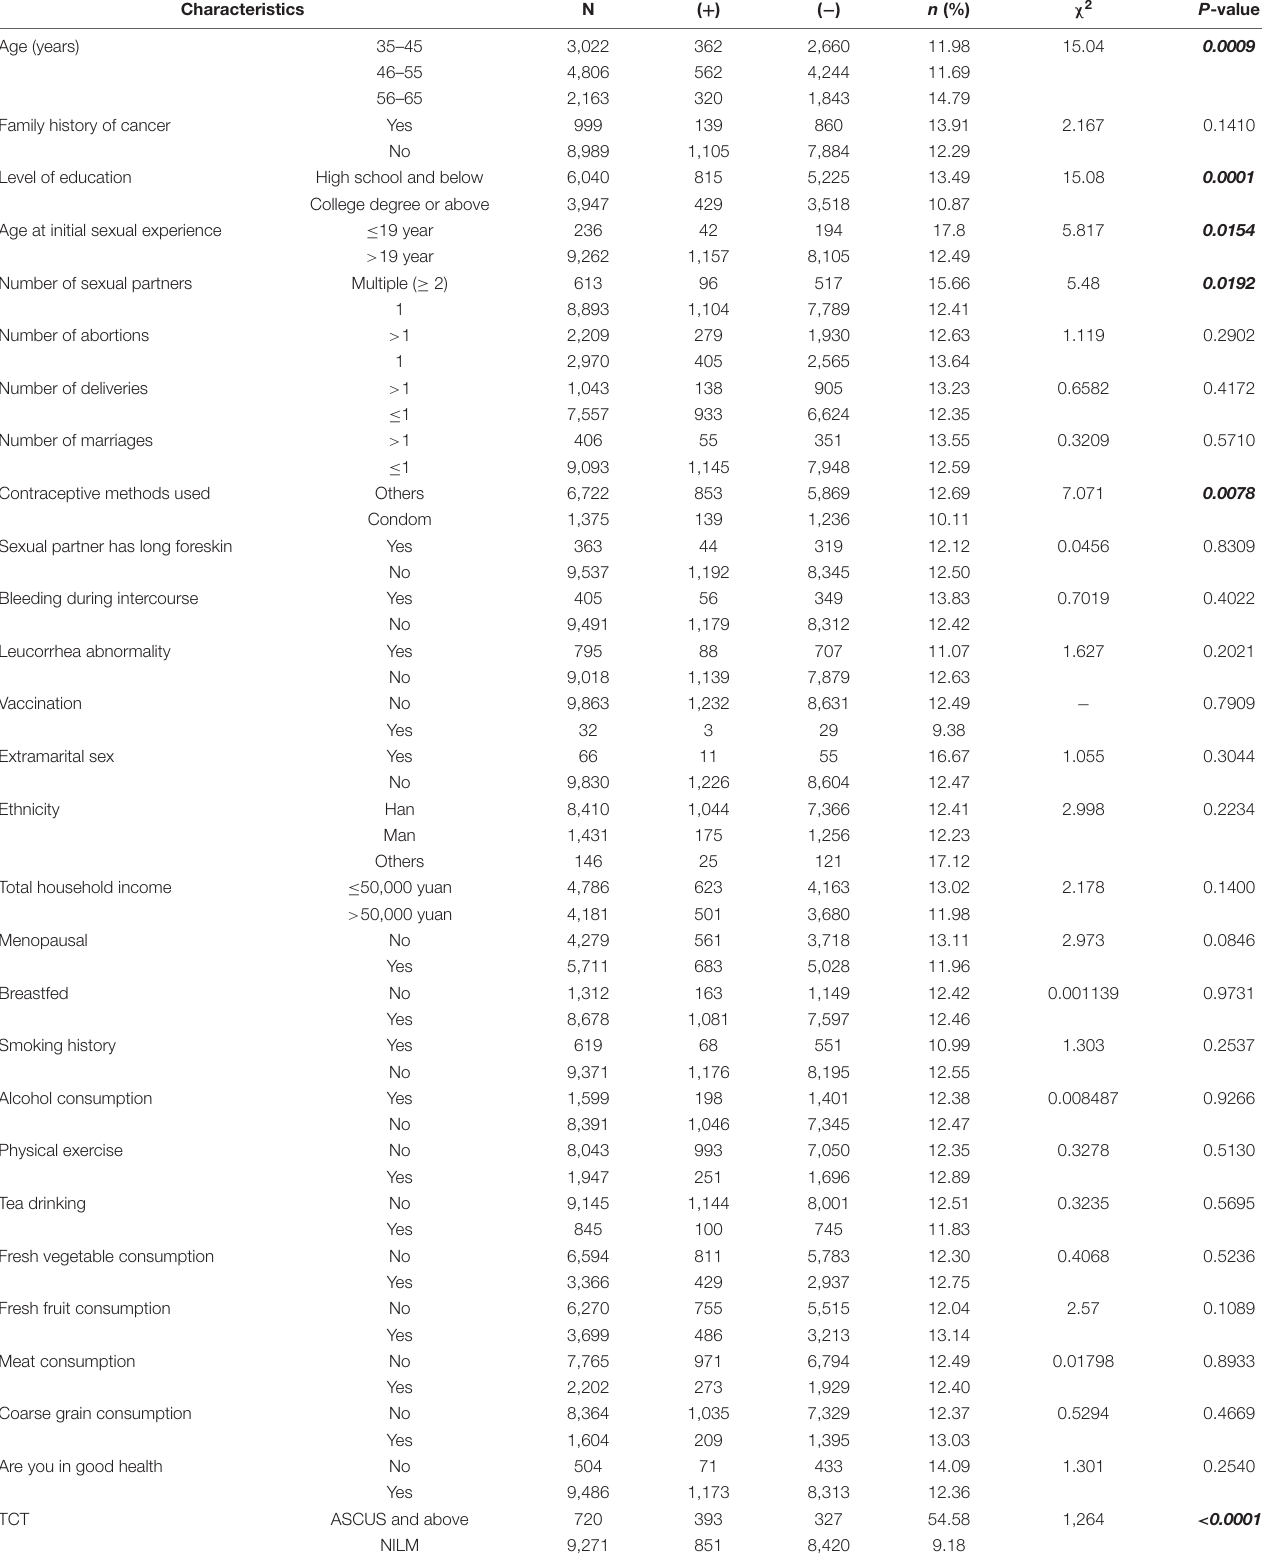
TABLE 10 | Comparison of different information and living habits with human papillomavirus (HPV) positive detection rate.